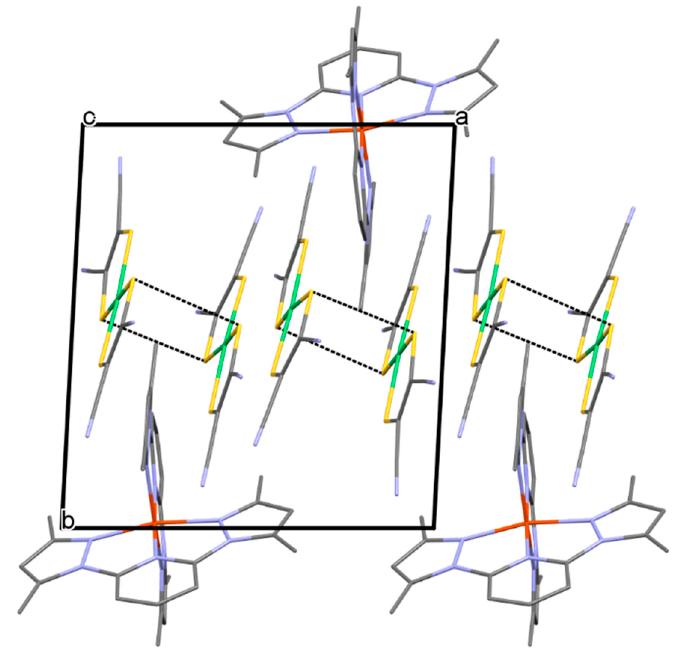
Figure 3. The crystal packing of compound 1 at 100 K. Short contacts between S atoms are indicated by black dotted lines. H atoms have been omitted for clarity.